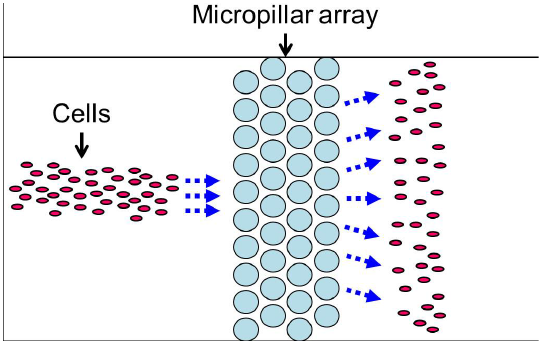
Figure 1. Concept of uniform cell dispersal by a micropillar array. The cells introduced into the microchamber are dispersed uniformly by the micropillar array. Blue arrows indicate the direction of cell